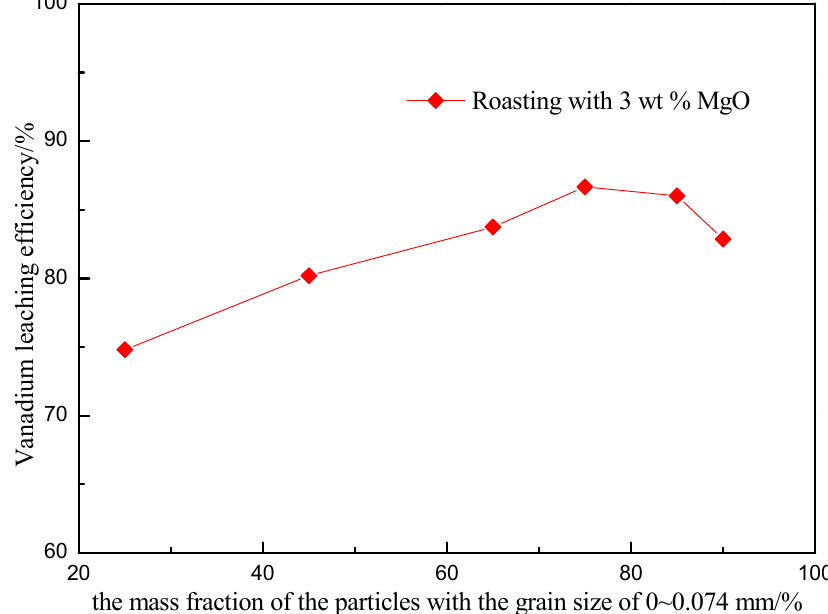
Figure 5. Effect of the particle size of raw ore on vanadium leaching efficiency.